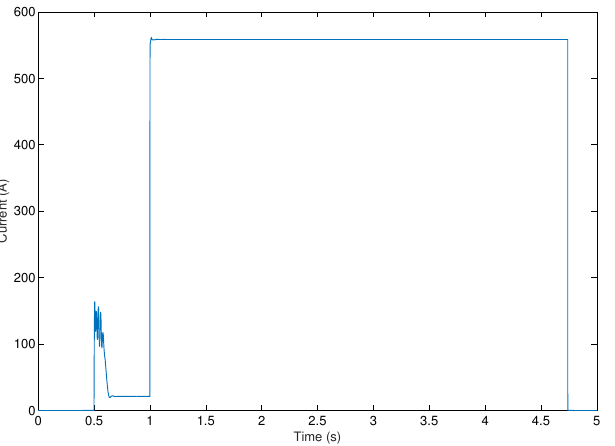
Figure 12. Inrush and fault current (RMS) passing “Square D QOB-3100” circuit